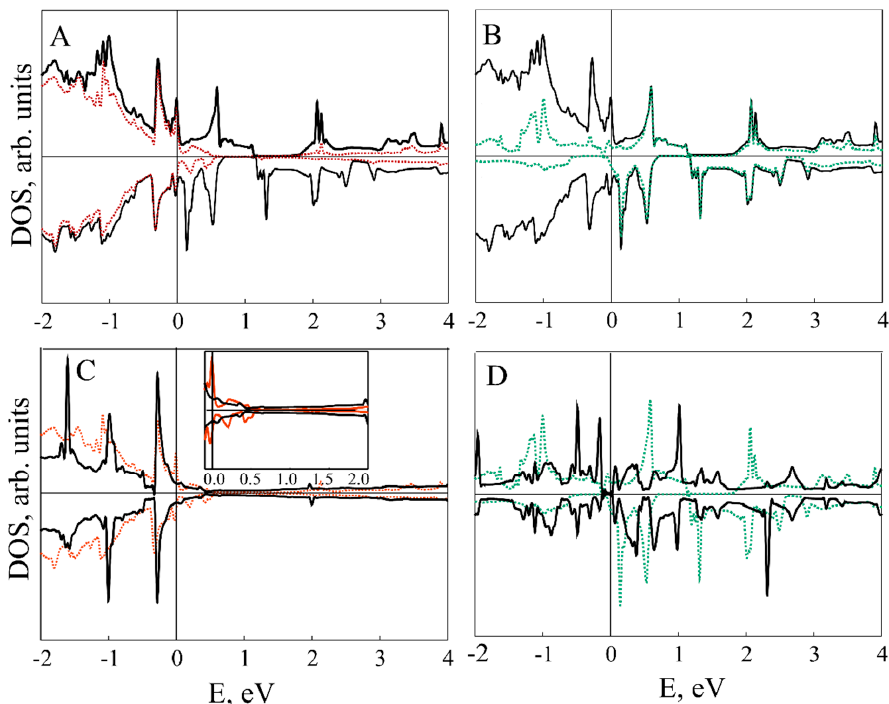
Figure 3. DOS for VP monolayer/ZnO composite. ( A ) Black and red lines correspond to composite TDOS and ZnO PDOS; ( B ) black and green lines correspond to composite TDOS and VP monolayer PDOS; ( C ) black and red lines correspond to TDOS of pristine ZnO slab and PDOS of ZnO fragment in VP monolayer/ZnO composite; ( D ) black and green lines correspond to TDOS of pristine VP monolayer and PDOS of VP in the composite structure, respectively.